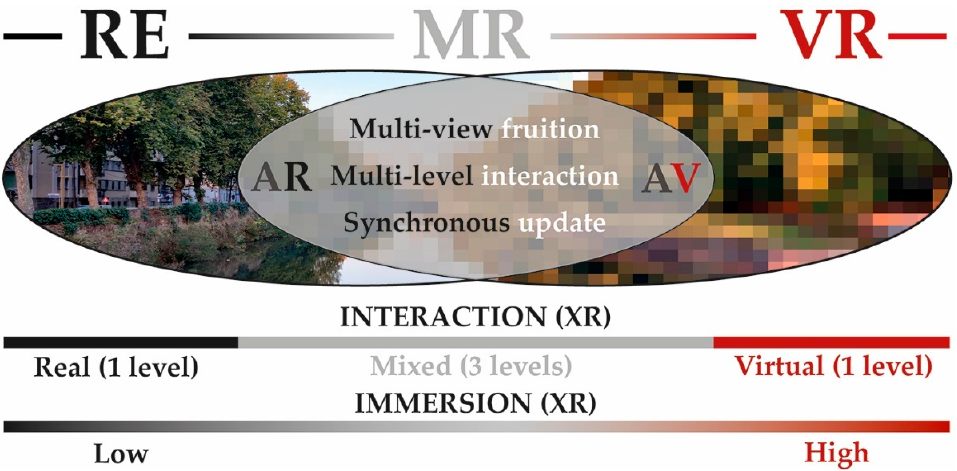
Figure 3. Diagram with the main features of AR, and its relationship to the real and virtual worlds.